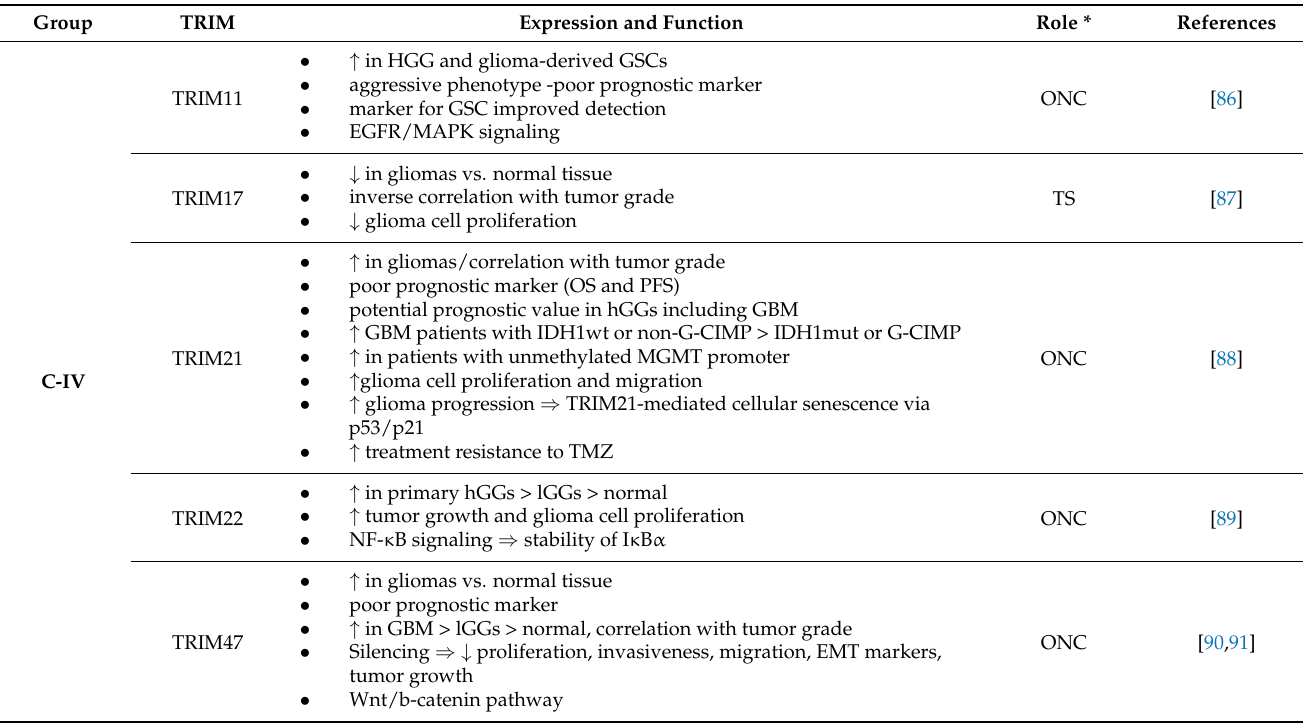
Table 2. Main TRIM protein family members implicated in gliomas. Expression and Function Role